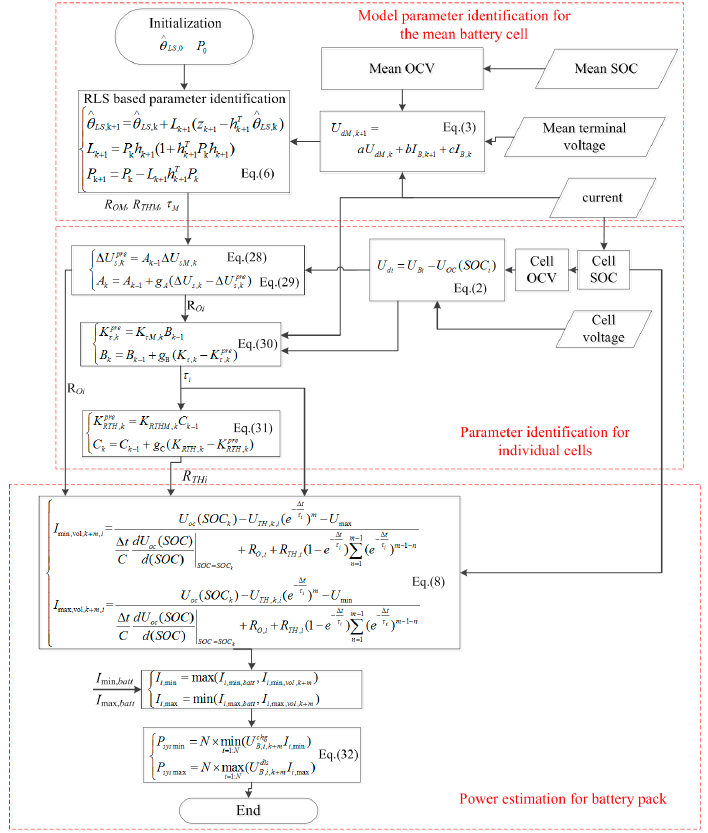
Figure 6. Power estimation of the battery pack consisting of series-connect battery cells considering cell difference.